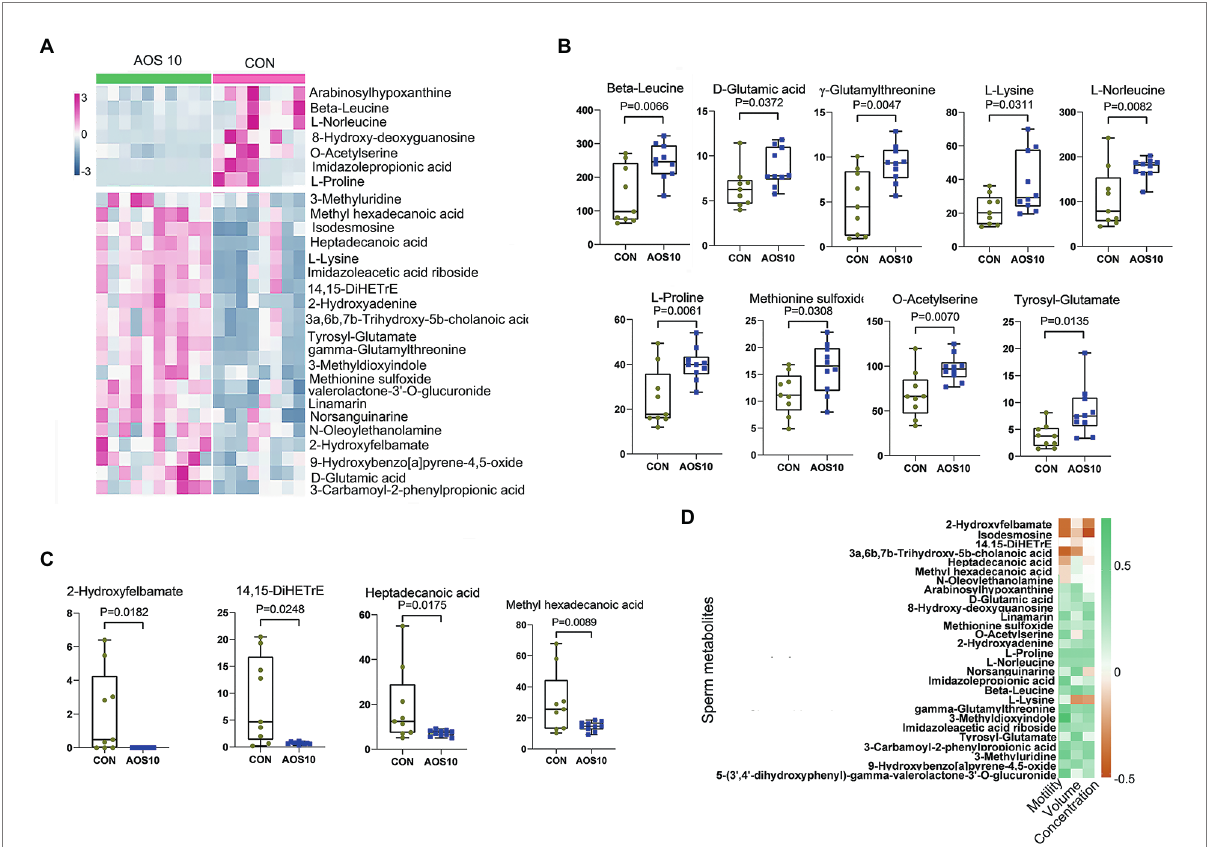
FIGURE 3 The impacts of AOS on boar sperm metabolome. (A) Heatmap of changed sperm metabolites. The sperm metabolites were determined by LC– MS/MS. (B) List of AOS increased sperm metabolites. Y-axis = relative amount, X-axis = treatment group (mg/kg body weight). (C) List of AOS decreased sperm metabolites. Y-axis = relative amount, X-axis = treatment group (mg/kg body weight). (D) Correlation of sperm metabolites and sperm concentration, volume, and